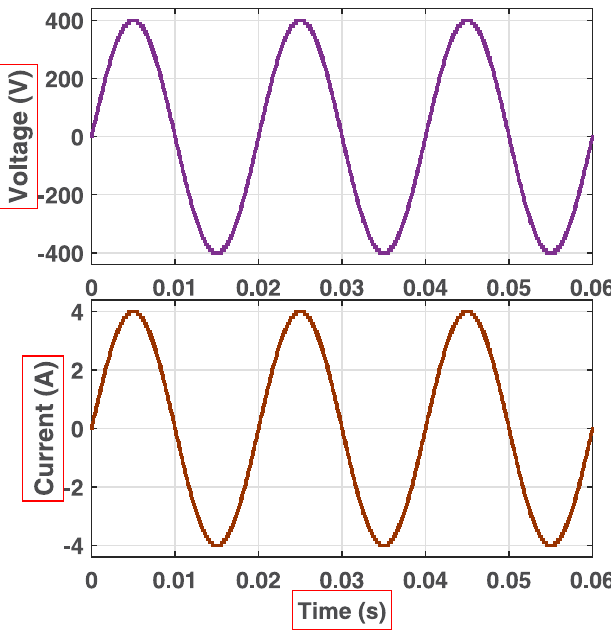
Fig 16. Simulation waveforms (voltage and current) at the output of 81-level MWMLI for R-load.